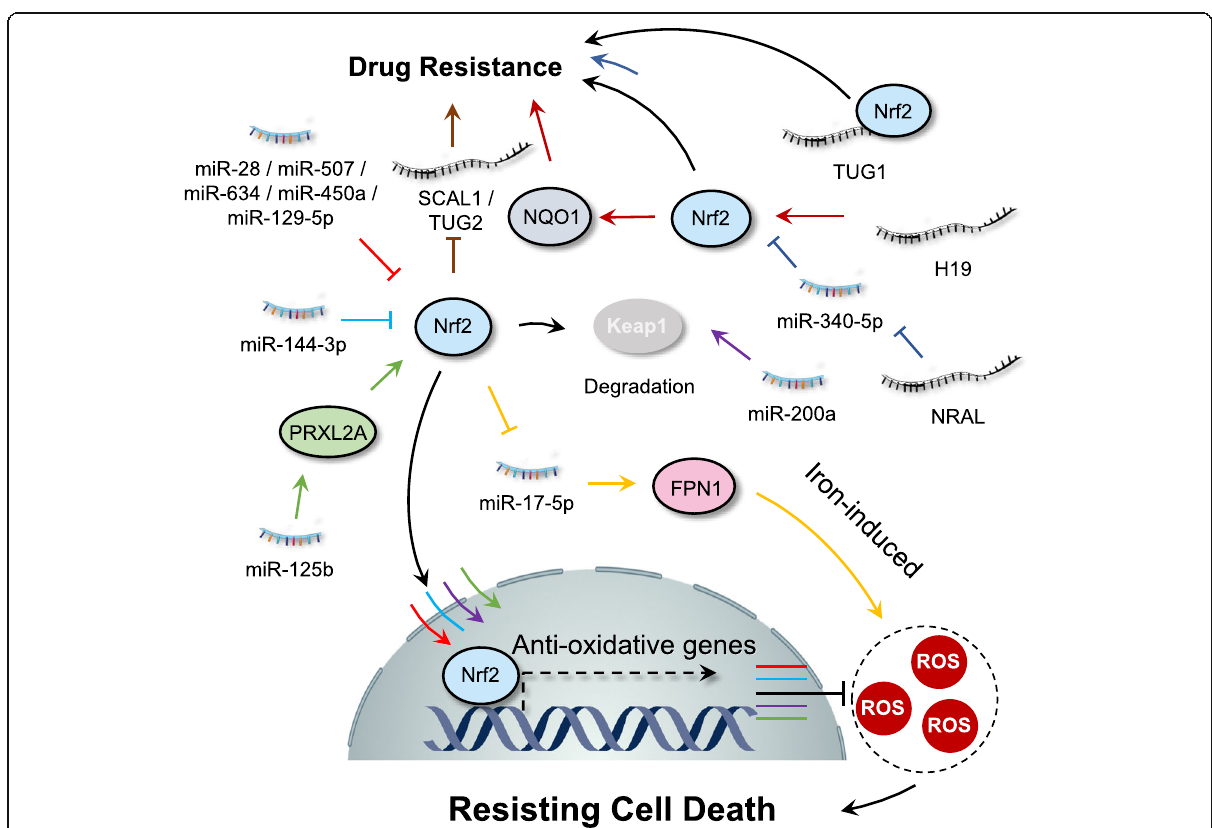
Fig. 3 Interplay between ROS and ncRNAs in regulating Nrf-2 pathway. The interaction between ncRNAs and ROS displays a crucial role for both positive or negative regulation of the Nrf-2 pathway which contributing to the cancer hallmark “ resisting cell death